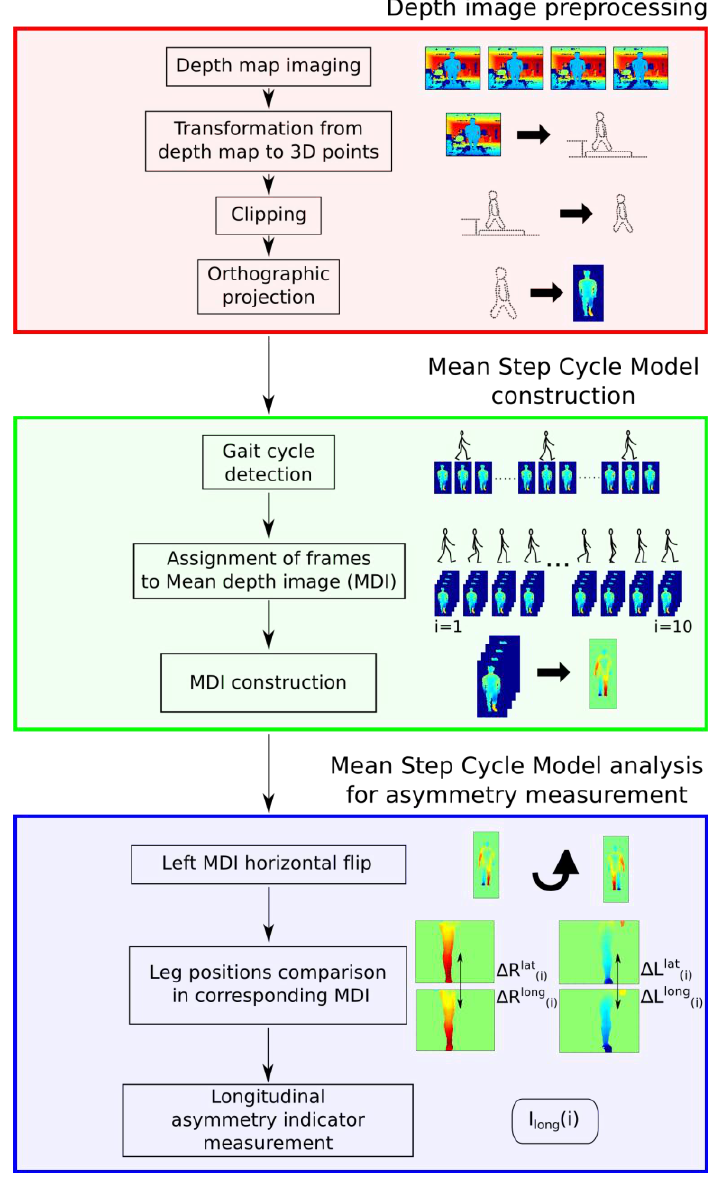
Figure 2. Representation of the method for measuring asymmetry indices of lower limbs during the step cycle. In the red box are the depth image pretreatment operations. In the green box are the mean step cycle model construction steps. Finally, in the blue box are the different operations to construct the asymmetry